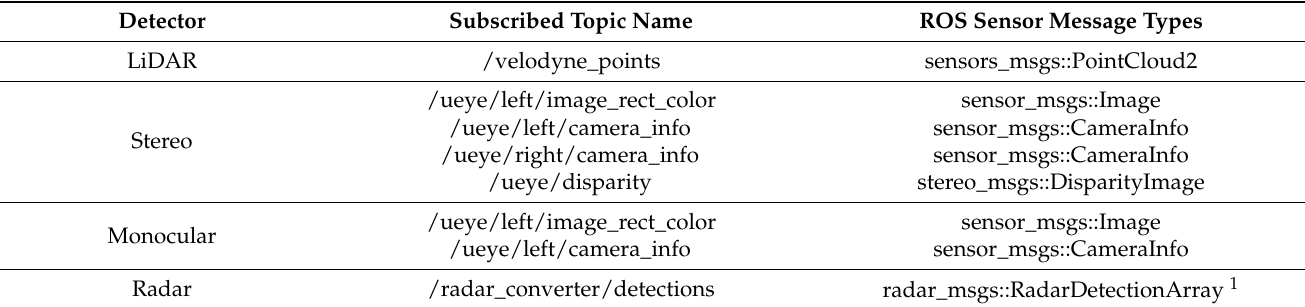
Figure 10. A graphical representation of the vertical laser points of the ( a ) Velodyne HDL-64E and the ( b ) Velodyne VLP-32C. Reference [145] utilizes the Velodyne HDL-64E which consists of 64 channels (layers), and the vertical laser beams are distributed uniformly across the vertical FoV between − 24.9 ◦ VLP-32C which consists of 32 channels (or layers) where the vertical laser beams are concentrated in the middle of the optical center across the vertical FoV between − 25 ◦ to 15 ◦ . Based on sensor user manual [68]. Table 6. An overview of the ROS topic message types as input requirements for each calibration board detector node, namely monocular camera detector (mono_detector), LiDAR detector (lidar_detector), stereo camera detector (stereo_detector), and radar detector (radar_detector). Based on reference [145,152]. A detailed overview of the ROS sensor message types is available in reference